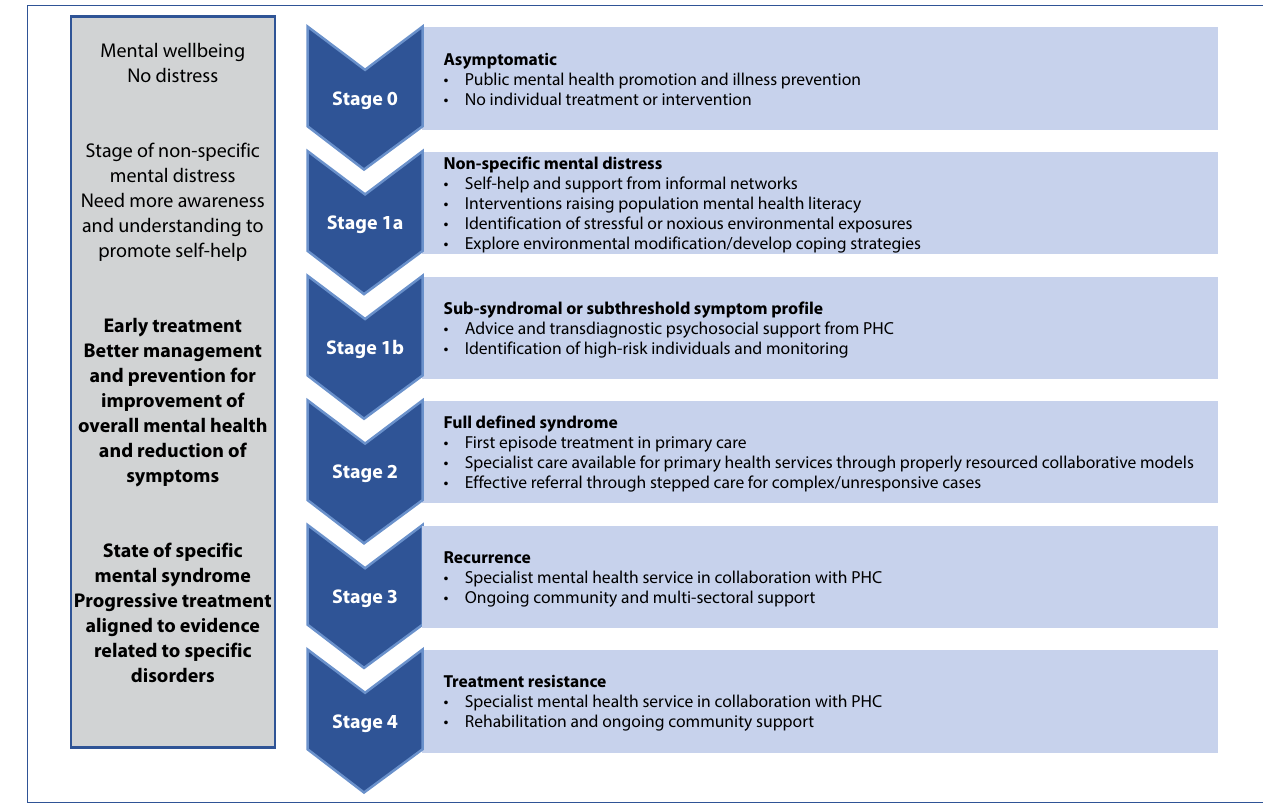
Figure 1. Staging of mental disorders